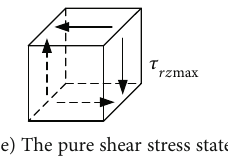
Figure 12: Stress state of dangerous points.